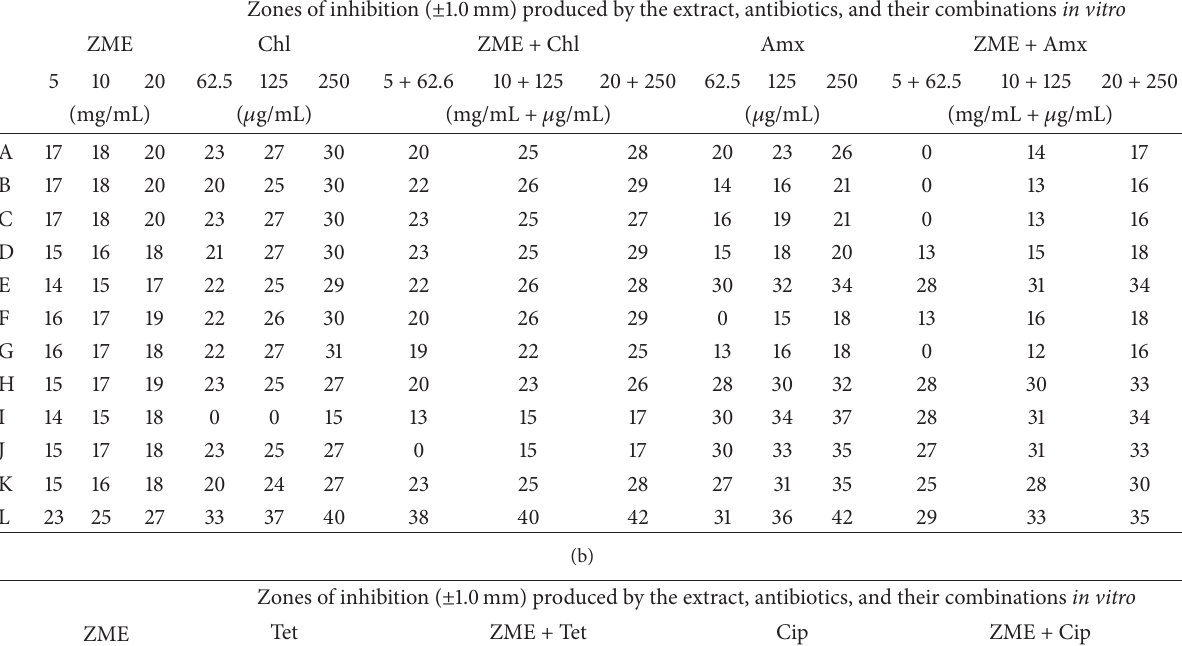
Table 1: Antibacterial effects of ethanolic extract of Z. mucronata alone, antibiotics alone, and their combinations. (a) Zones of inhibition ( ± 1.0mm) produced by the extract, antibiotics, and their combinations in